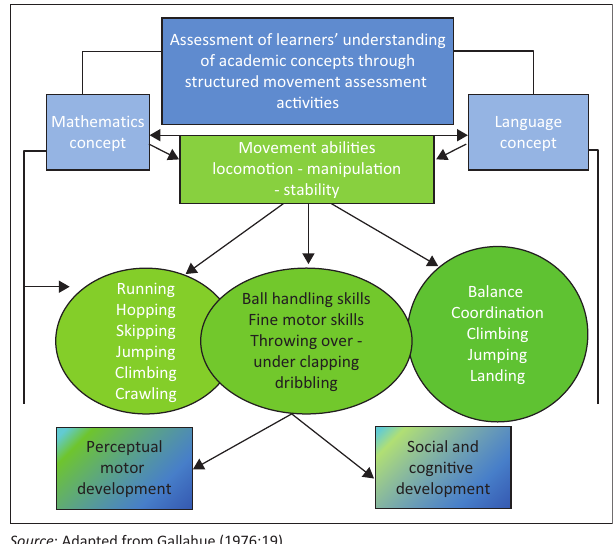
FIGURE 1: Conceptual framework of structured movement educational